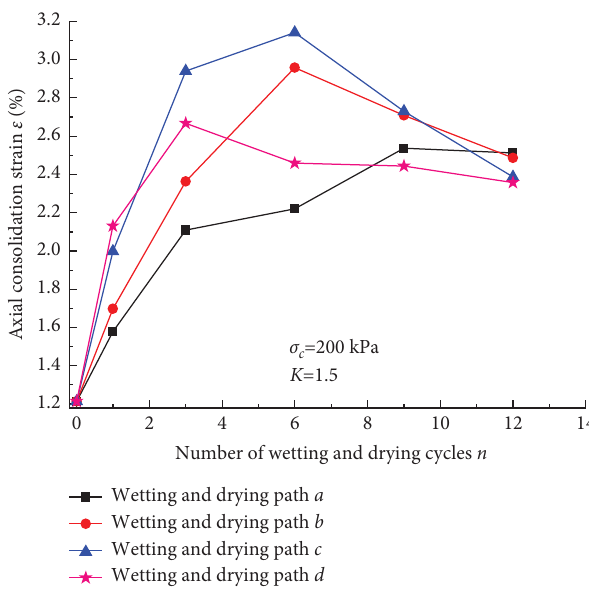
Figure 11: Te axial consolidation strain of diferent W - D cyclic paths ( σ c � 200kPa, K �